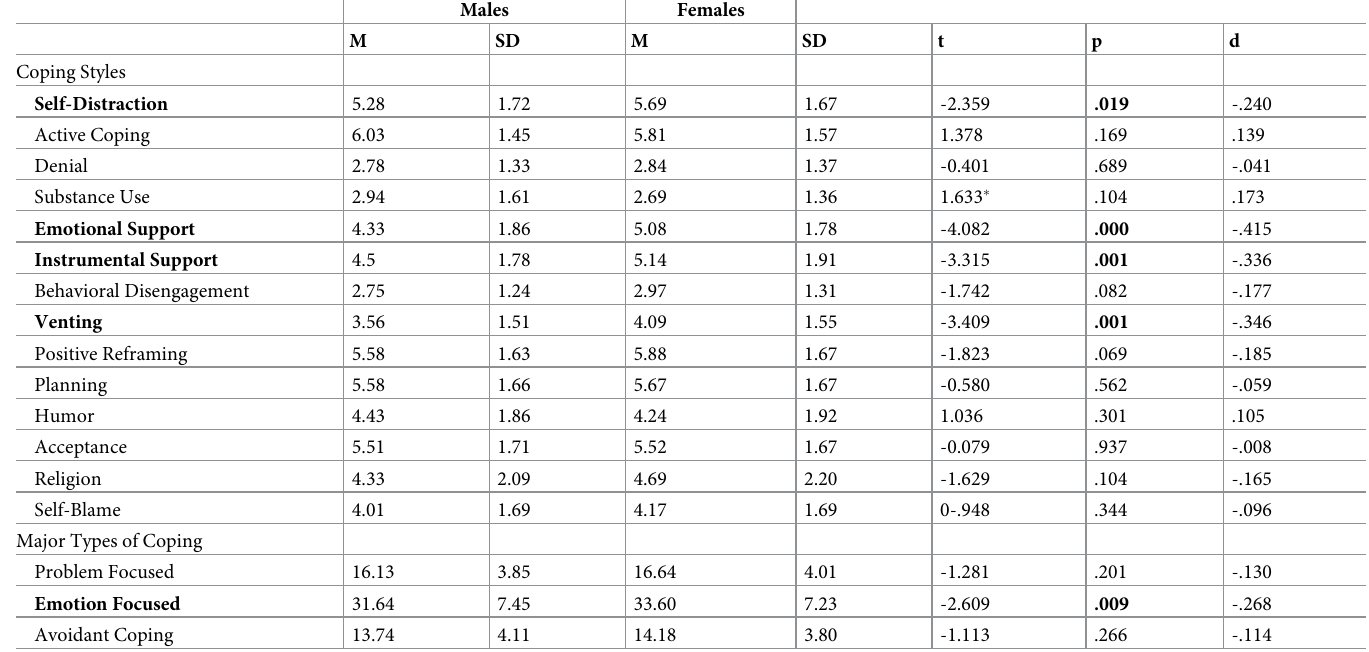
Table 3. Differences between male and female students on coping